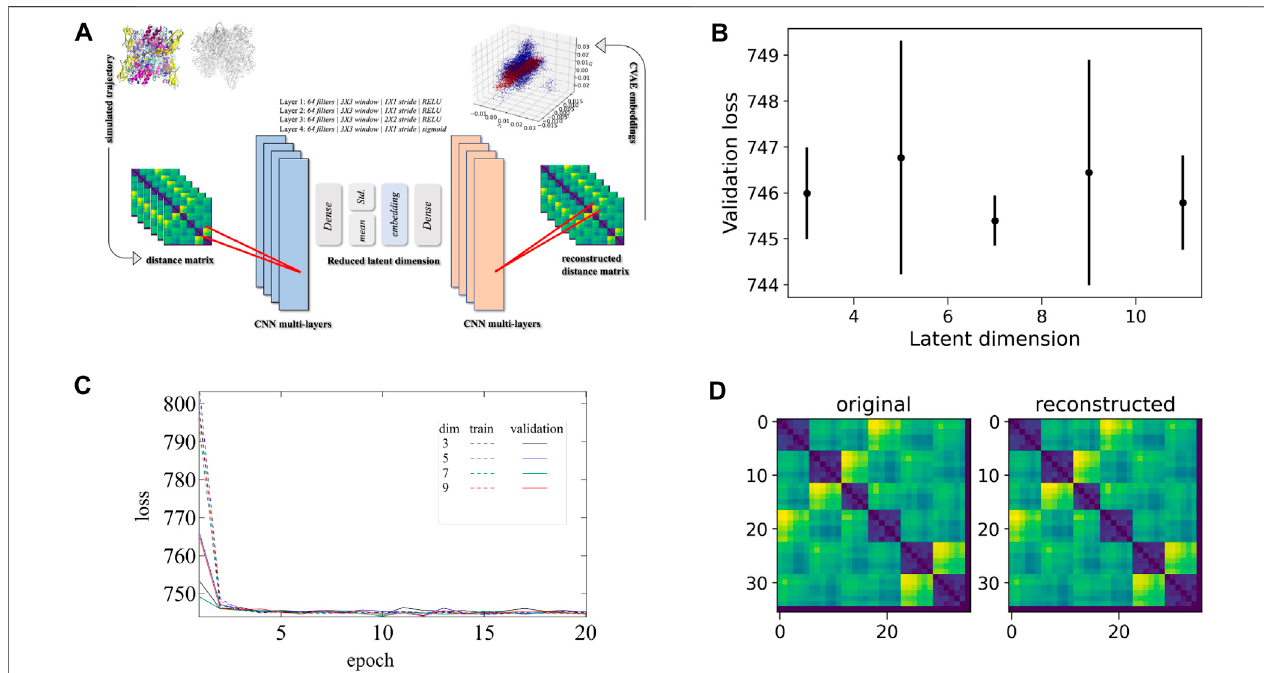
FIGURE 3 | CVAE-based deep learning implementation. (A) The CVAE implementation where distance matrix is used as input data for generating the low- dimensional representations. The input data is initially trained where the quality of training is followed by the different loss values at different dimensions over epochs. (B) Thevalidationlossisshownatdifferentlatentdimensionsfordeterminingtheoptimumvaluesofthelowdimension. (C) Thetrainingandvalidationlossareassessedover epochsat various dimensions. (D) Comparison betweenoriginalinputdataand reconstructeddata areshown toensure no loss ofessential information during the compression and reconstruction